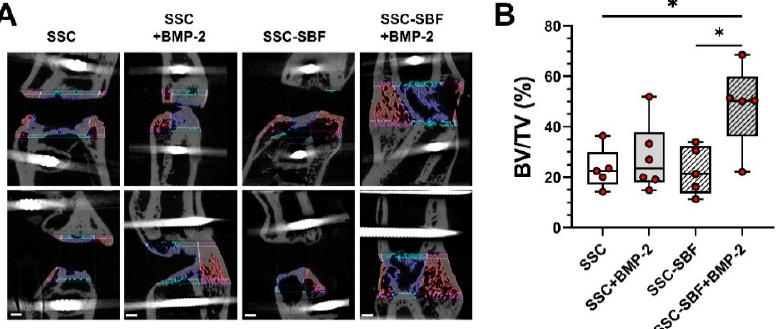
Figure 5. ( A ) µ CT images in two planes showing the defect region for a representative specimen of each treatment group (10 weeks after surgery). The color-coded regions delineate the regions included for quantification of the bone volume (blue: defect bone volume; red: bone callus volume; pink and turquoise: bone margins; scale bar = 1 mm); ( B ) BV/TV measurements determined for the different treatment groups 10 weeks after treatment ( n = 5–6); * p < 0.05 (one-way ANOVA).